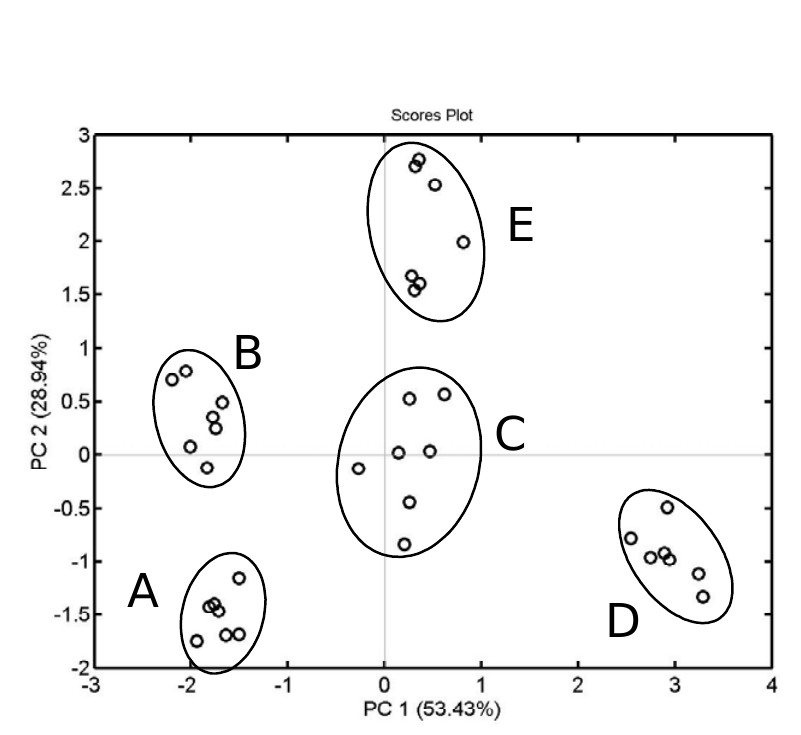
Figure 4. Principal component analysis (PCA) score plot for different artificial waters measured with a 6-electrode